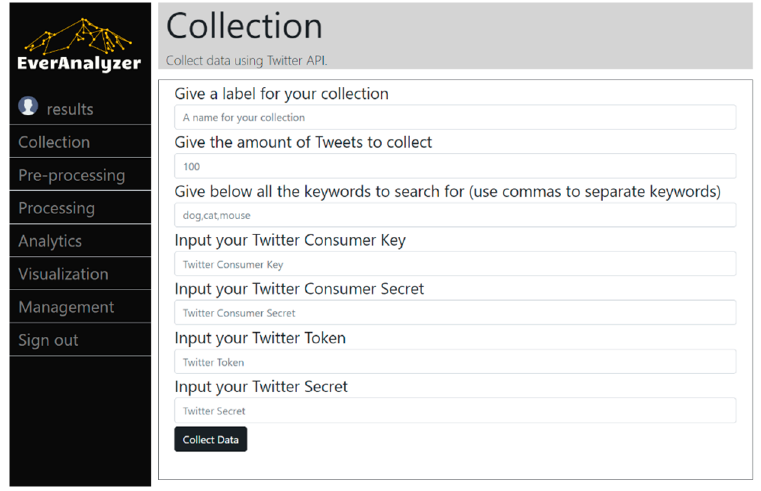
Figure 15. Collection Interface.